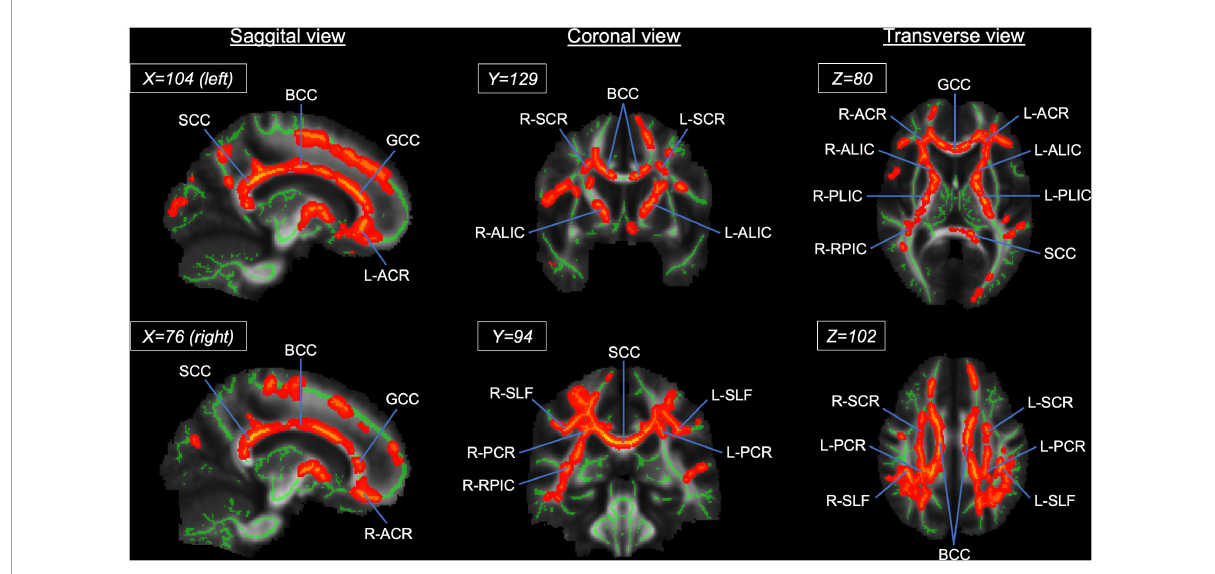
FIGURE4 Results from tract-based spatial statistics (TBSS) analysis showing significant white matter skeletons (red) where the athlete group had higher FA than the sedentary group. The coordinates are based on the JHU ICBM-DTI-81 White-Matter atlas. Significant skeletons were thickened for visualization. ACR, anterior corona radiata; ALIC, anterior limb of internal capsule; BCC, body of corpus callosum; FA, fractional anisotropy; GCC, genu of corpus callosum; PCR, posterior corona radiata; RPIC, retrolenticular part of internal capsule; SCC, splenium of corpus callosum; SCR, superior corona radiata; SLF, superior longitudinal fasciculus. L and R denote the right and left hemispheres.